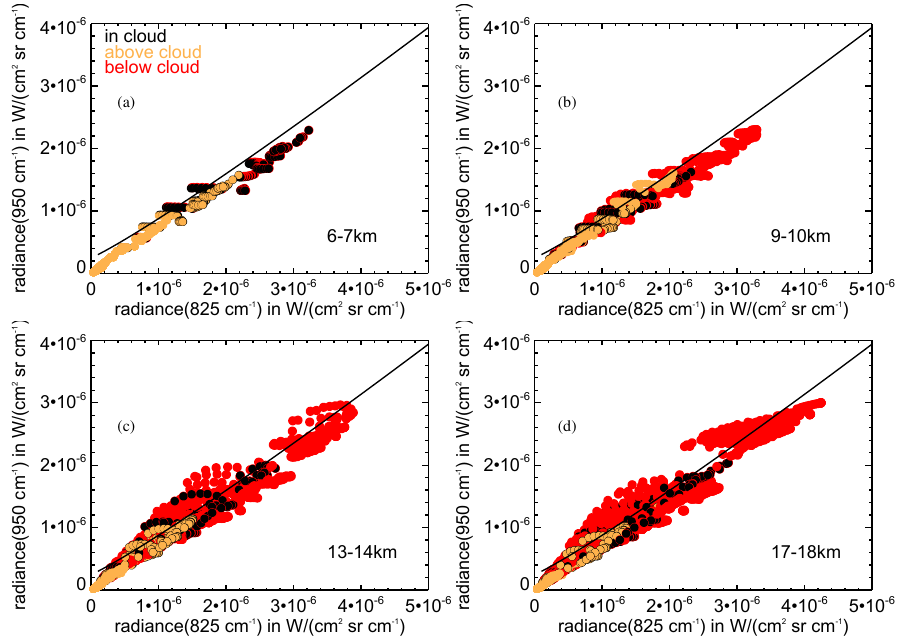
Figure 10. Simulated radiances for ash clouds. (a) Ash layer at 6–7km altitude in polar winter, polar summer and mid-latitude atmosphere. (b) Ash layer at 9–10km altitude in polar winter, polar summer and mid-latitude atmosphere. (c) Ash layer at 13–14km altitude in polar winter, polar summer, mid-latitude and equatorial atmosphere. (d) Ash layer at 17–18km altitude in polar winter, polar summer, mid-latitude, and equatorial atmosphere. The black line is the ash detection threshold. The tangent altitudes from the ash layer bottom to 6km are coloured in red, the tangent altitudes within the ash layer are coloured in black, and tangent altitudes above the ash layer are coloured in orange.